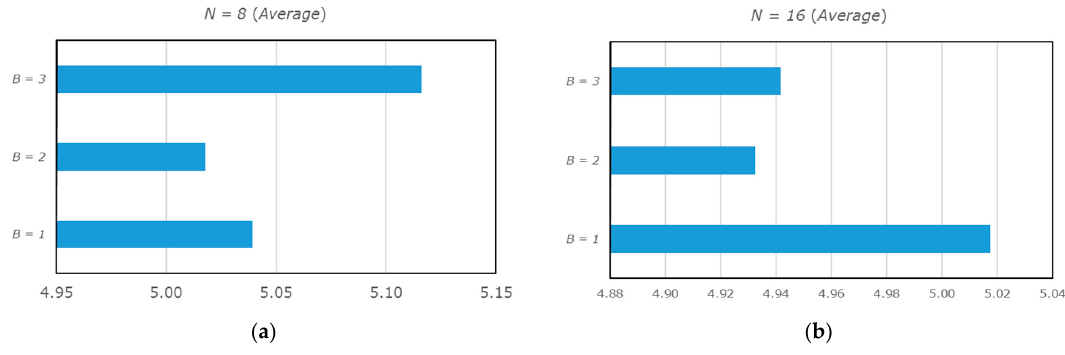
Figure 5. Graphical representation of the average results by using the PAQ8 scheme for the coding of the prediction errors. N “ 8 ( a ) and N “ 16 ( b ).